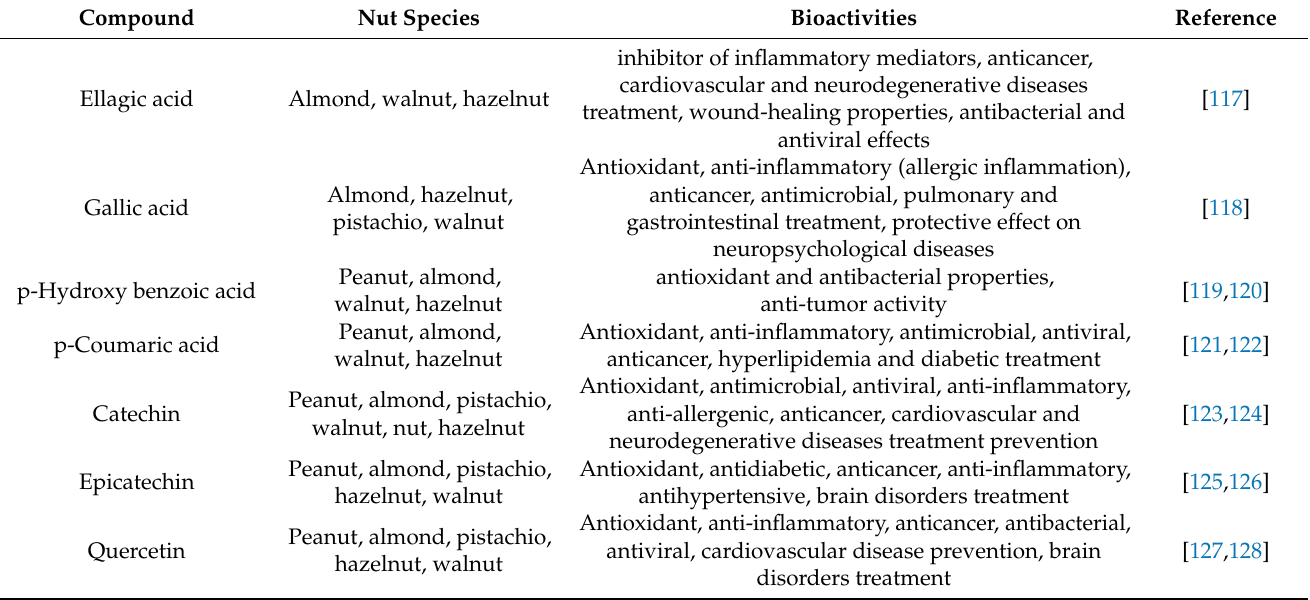
Table 3. Main nut polyphenols and their